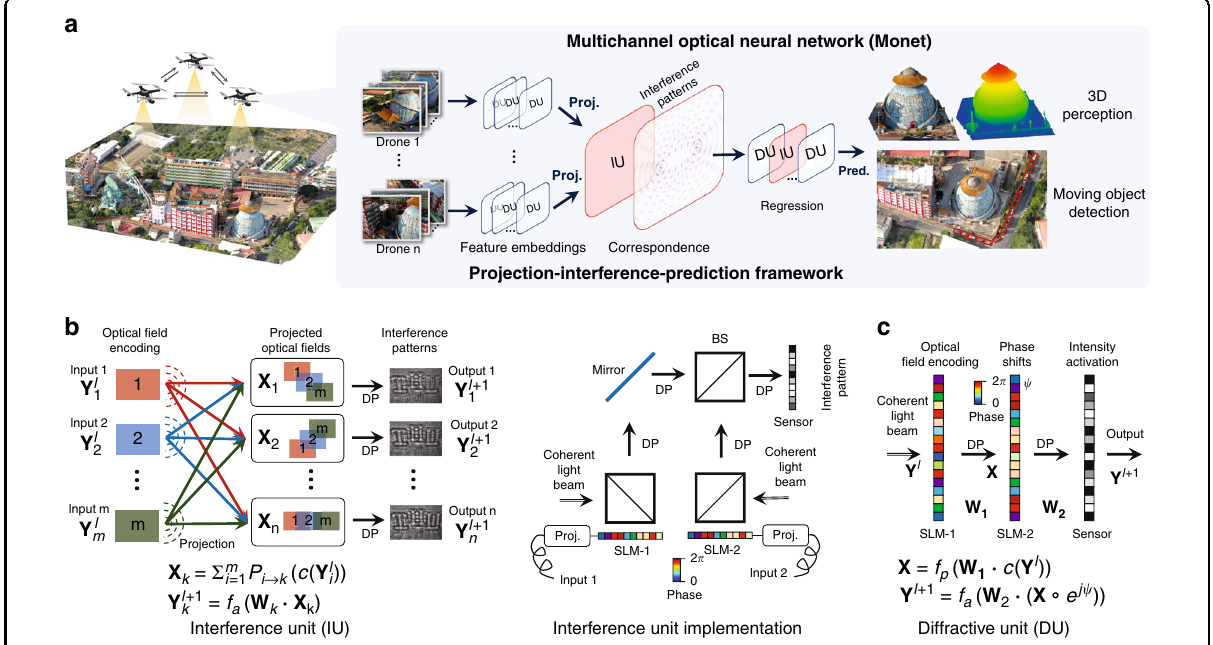
Fig. 1 A multichannel optical neural network (Monet) architecture for advanced machine vision tasks. a Network architecture of Monet and the projection-interference-prediction framework. Multiple observations are projected to a shared domain and encoded into optical fi elds, processed by interference units (IUs) for correspondence constructions and diffractive units (DUs) for feature embeddings. A regression module composed of iteratively connected IUs and DUs is adopted to predict the results for 3D perception or moving object detection. b Schematic and physical implementation of the IU (two-input). Multiple optical fi elds encoding multiple images are projected by task-speci fi c function, propagate, and interfere to generate interference patterns. Different colours (red, green, blue) denote different visual inputs. In the physical implementation, two spatial light modulators are used to generate and project the optical fi elds, and a sensor is used to capture the interference pattern. c Schematic of the DU. A coherent light beam is modulated by SLM-1 to encode the input image, propagates to the SLM-2 for modulation, and propagates to the sensor for activation. DP diffractive propagation, BS beam splitter, Proj projection, Pred